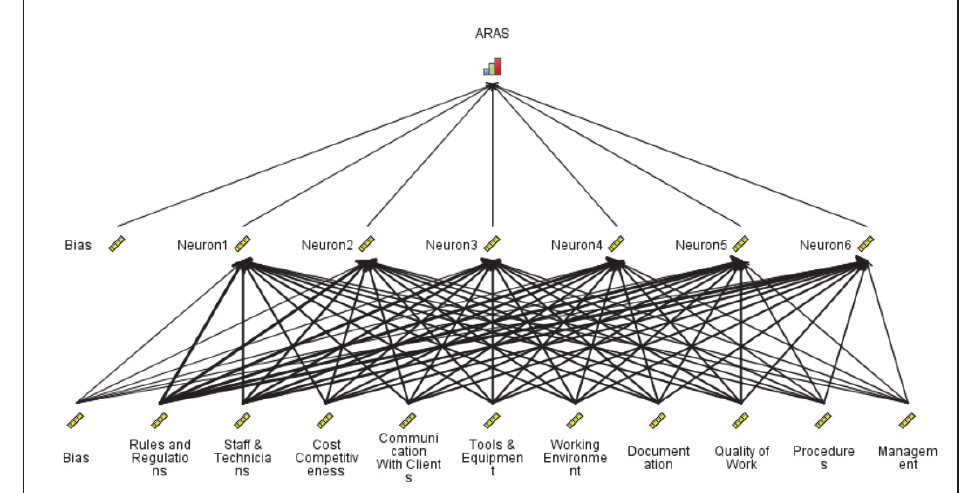
Fig. 3. Multilayer perceptron neural